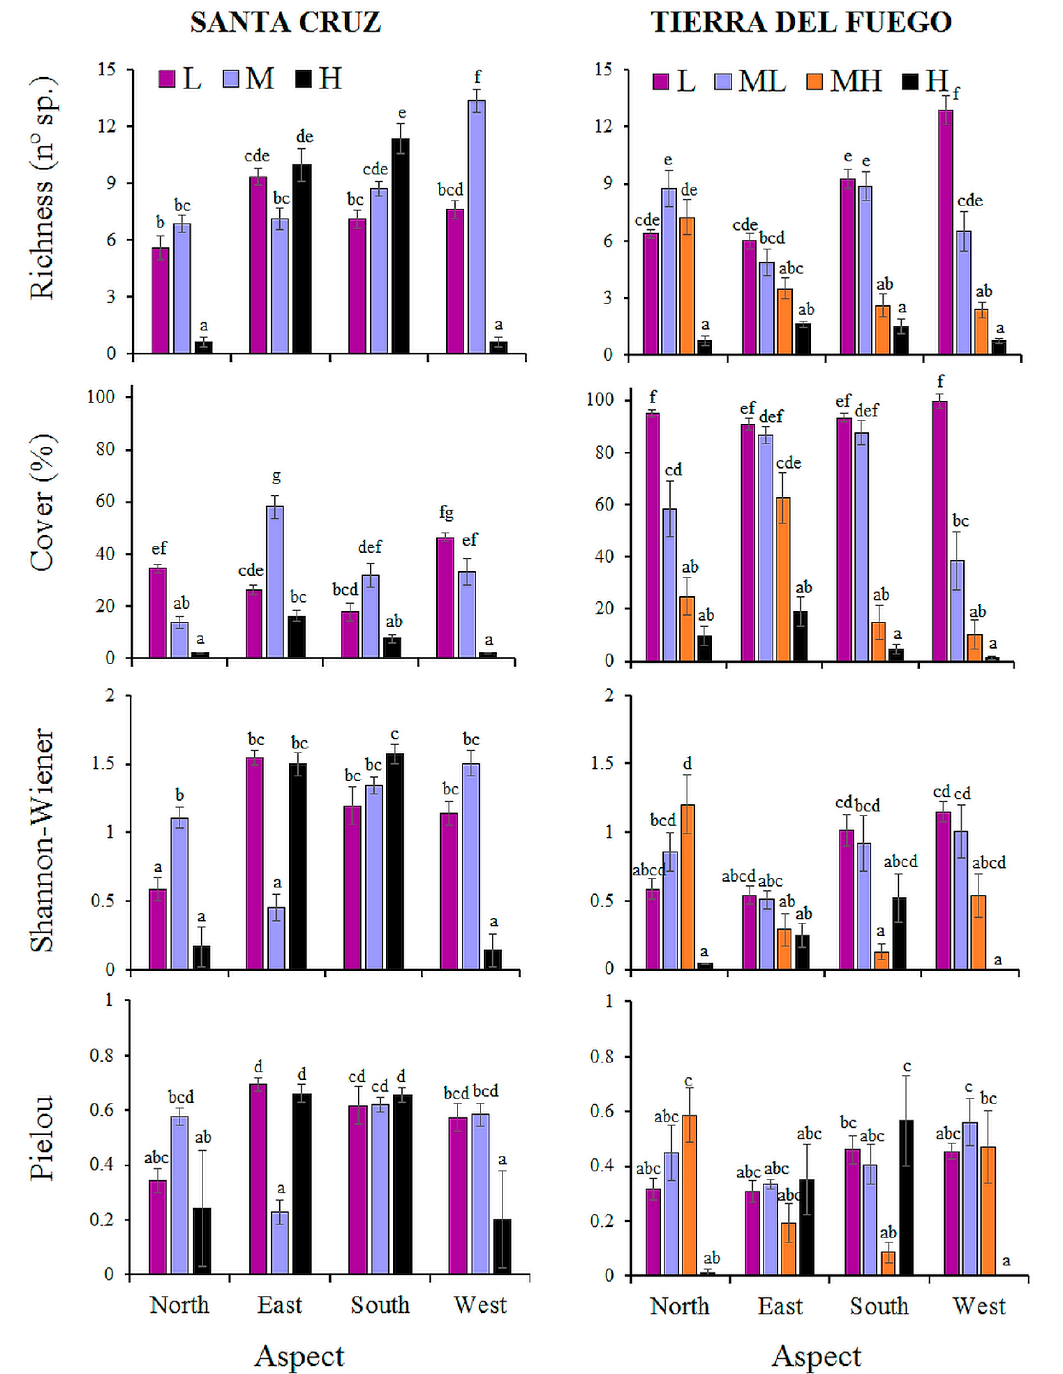
Figure 2. Interaction graphs of elevation × cardinal aspect including the entire survey information (baseline and re-sampling data), for richness (number of species), cover (%), and diversity indices (Shannon-Wiener, Pielou evenness) of alpine vascular plants in South Patagonia mountain sites, immersed in grassland (Santa Cruz) or forest (Tierra del Fuego) landscapes, according to a three-way ANOVA results shown in Table 2 (n = 8; N = 96 for Santa Cruz and N = 124 for Tierra del Fuego). Elevation: L = low, M = medium, ML = medium-low, MH = medium-high, H = high; cardinal aspect: north, east, south, west. Some very low values are slightly exaggerated to improve the visual representation of the data. Error bars represent ± standard error. Different letters in each graph indicate significant differences ( p < 0.05) by the Tukey test. In SC, the interaction between the summit and sampling date for evenness index occurred because values decrease with elevation gain in the baseline (from 0.55 to 0.42